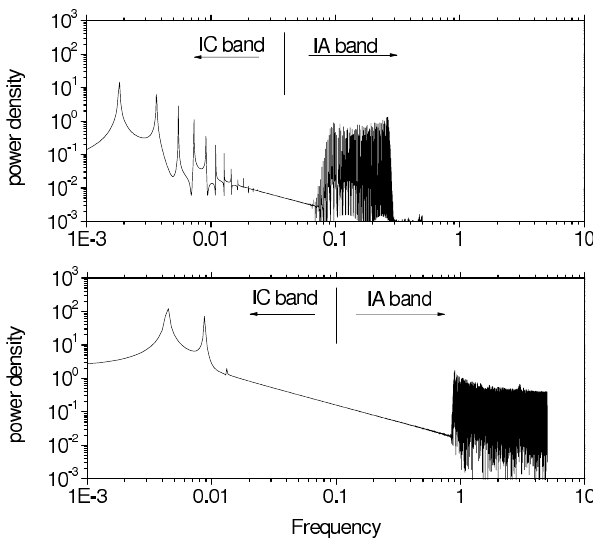
Fig. 9. FFT spectra of the sawtooth (upper panel) and bipolar (lower panel) E x solitary